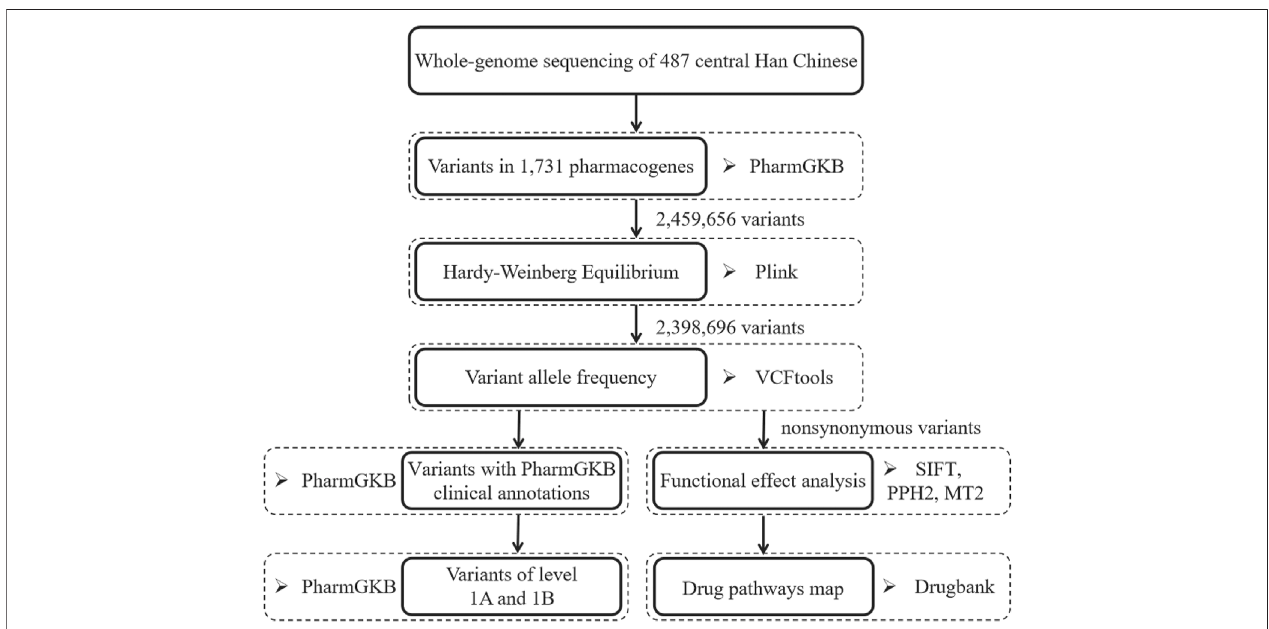
FIGURE 1 | The overview of analysis work fl ow for pharmacogenomic variant in the central Han Chinese population. PPH2, PolyPhen2. MT2, Mutation Taster 2.